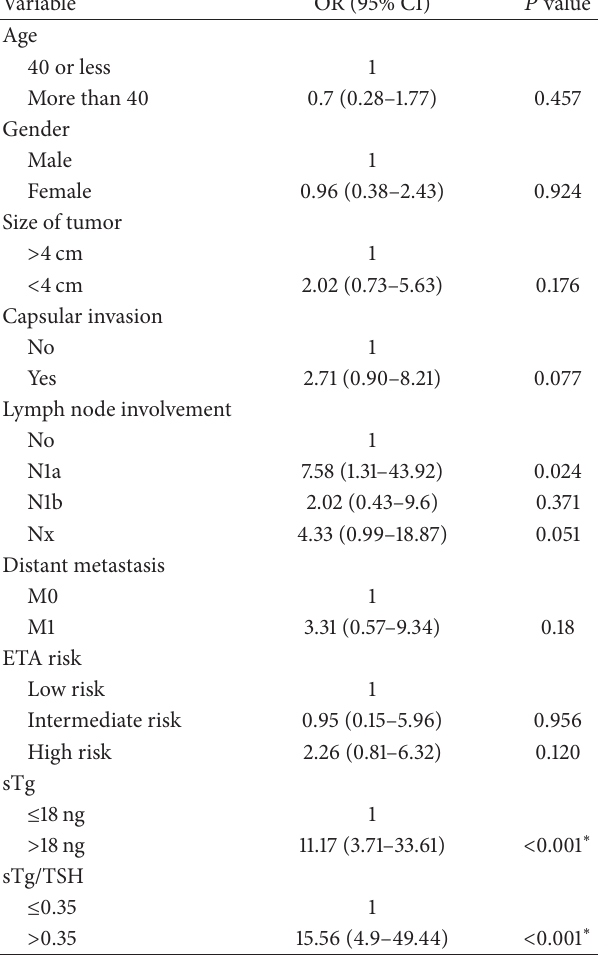
Table 3: Univariate analysis of various patient and tumor character- istics and unsuccessful ablation.